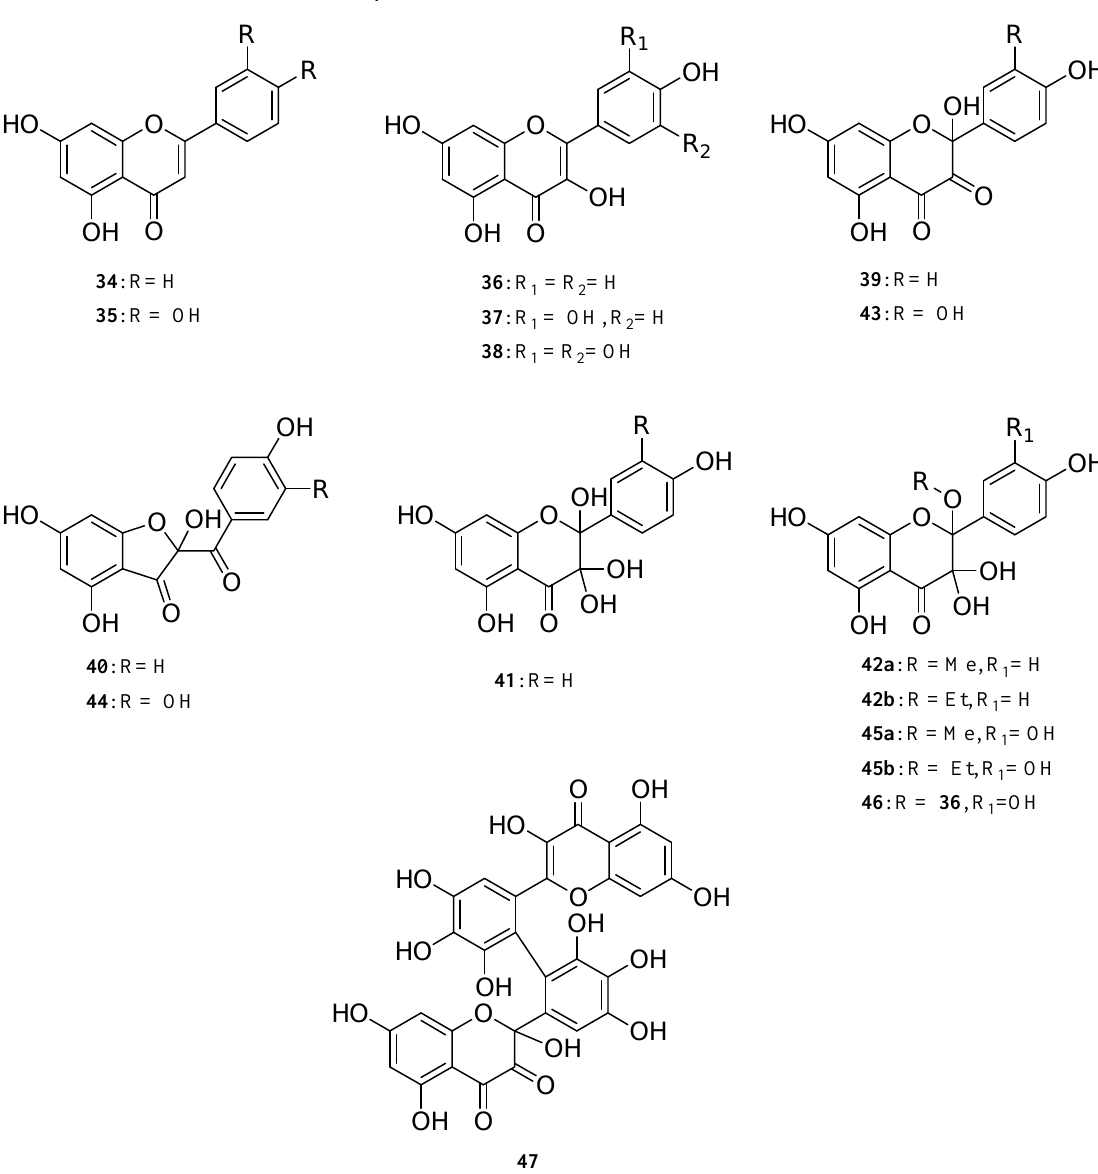
Figure 8. Structures of the flavonoids studied in the enzymatic oxidation. The structures of the obtained oxidized compounds are also